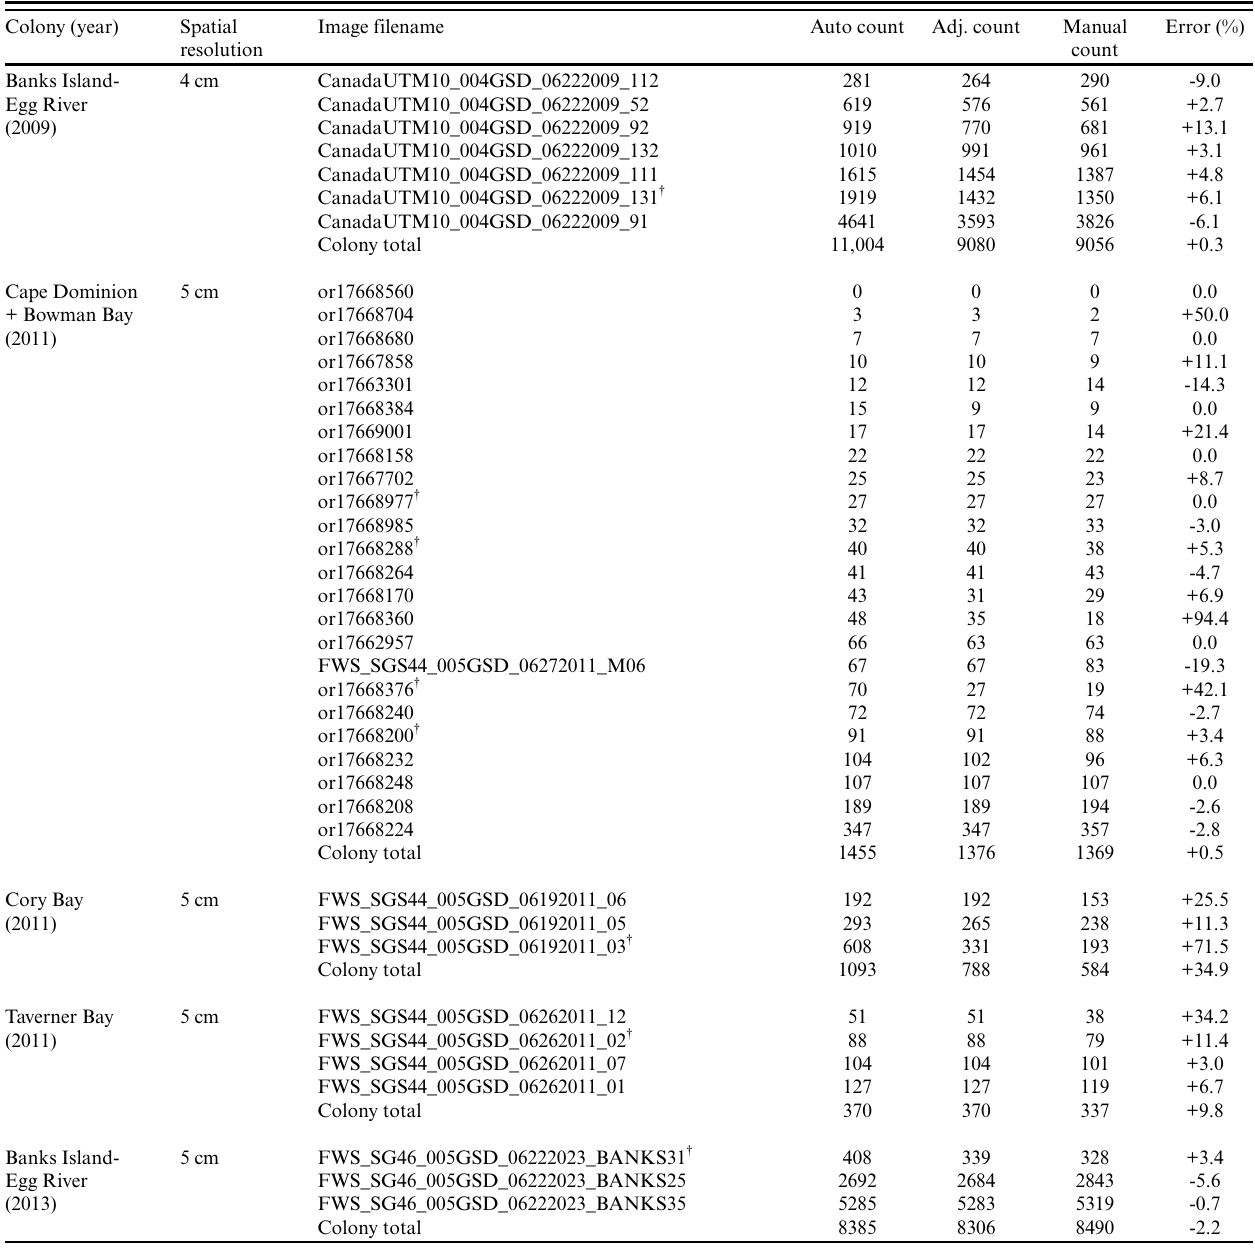
Table 1 . Comparison of computer-automated Lesser Snow Goose ( Chen caerulescens caerulescens ) counts, adjusted counts in which conspicuous clusters of commissions errors have been removed, and fully manual counts in 41 aerial images of breeding colonies in the Canadian Arctic. Image filenames beginning with “or” are single orthophotos whereas others are multiphoto orthomosaics. Colony